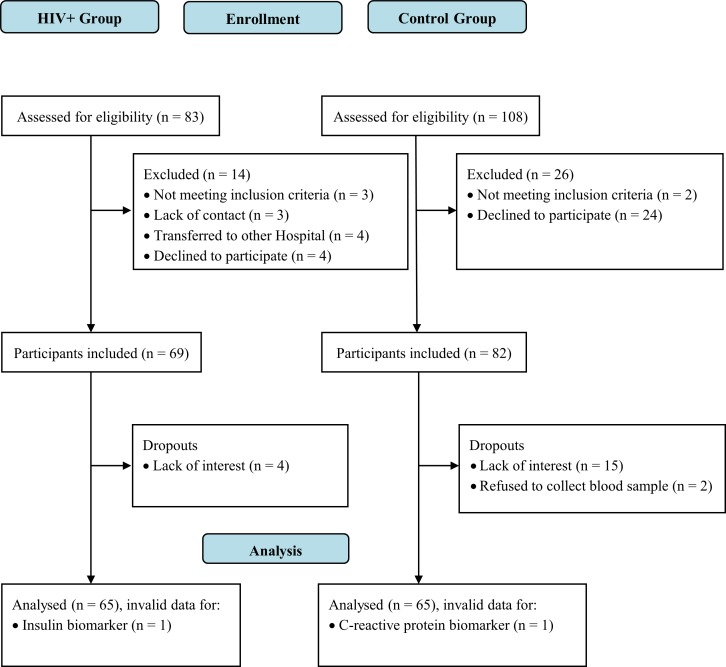
Flowchart of participants.PositHIVe Health Study.